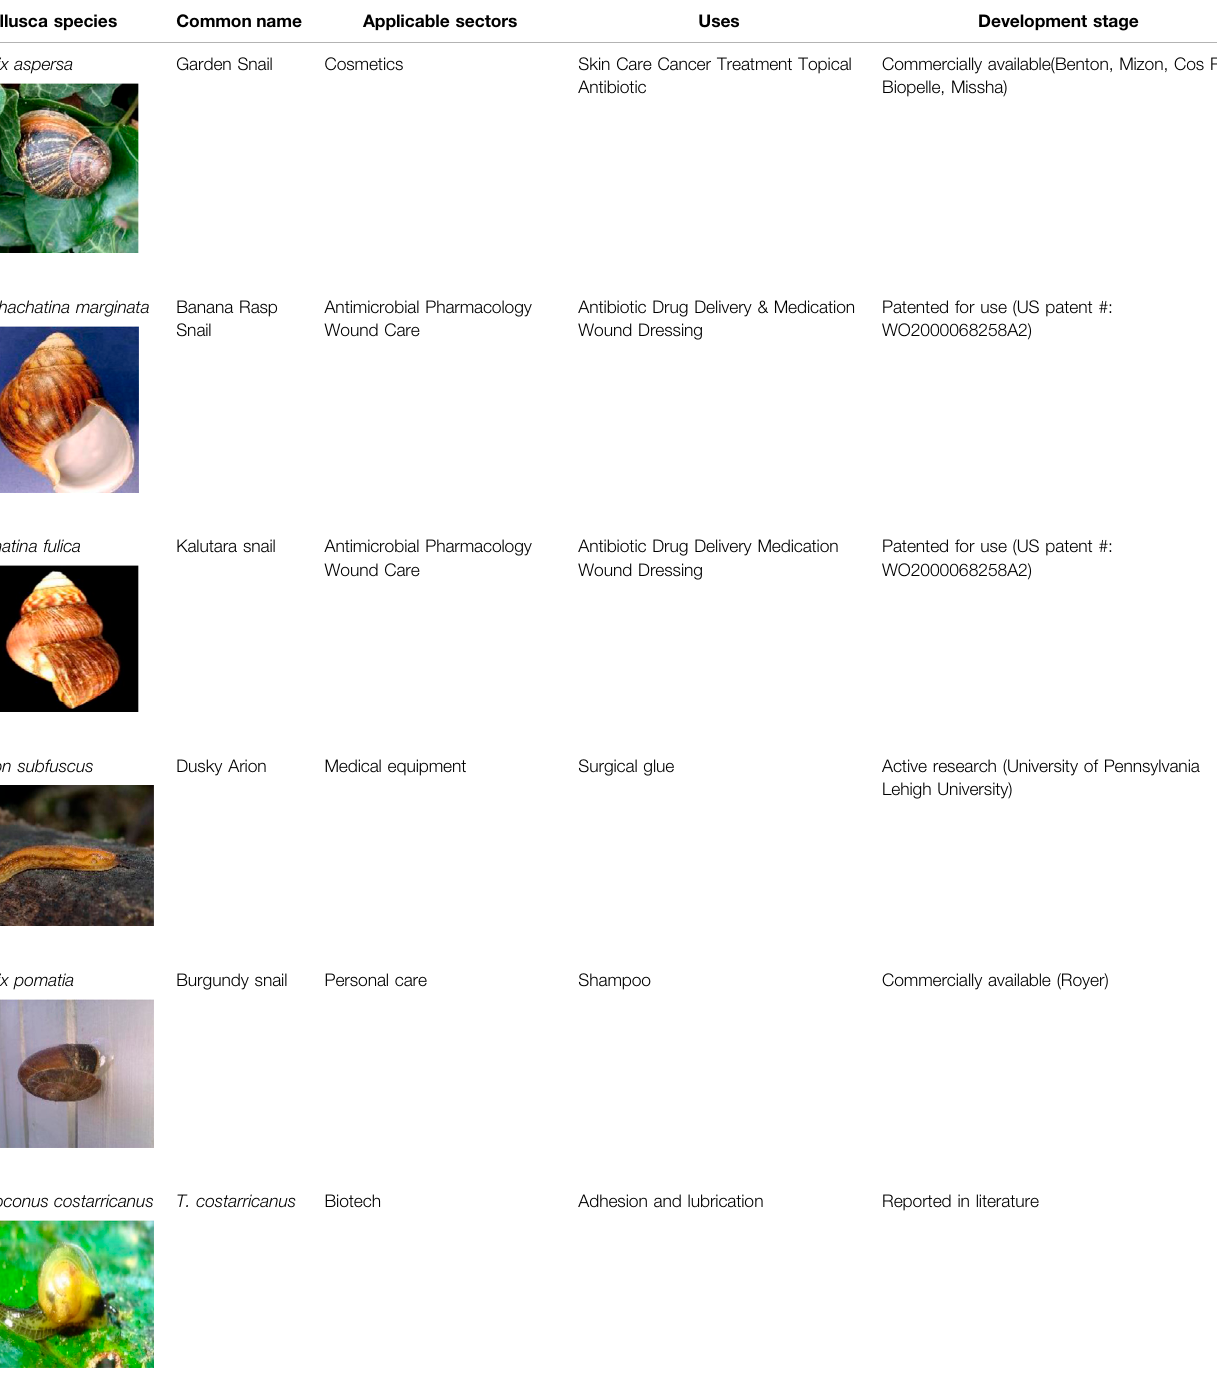
TABLE 1 | Mollusca species whose mucin have been applied in various sectors for biomedical or biotechnology